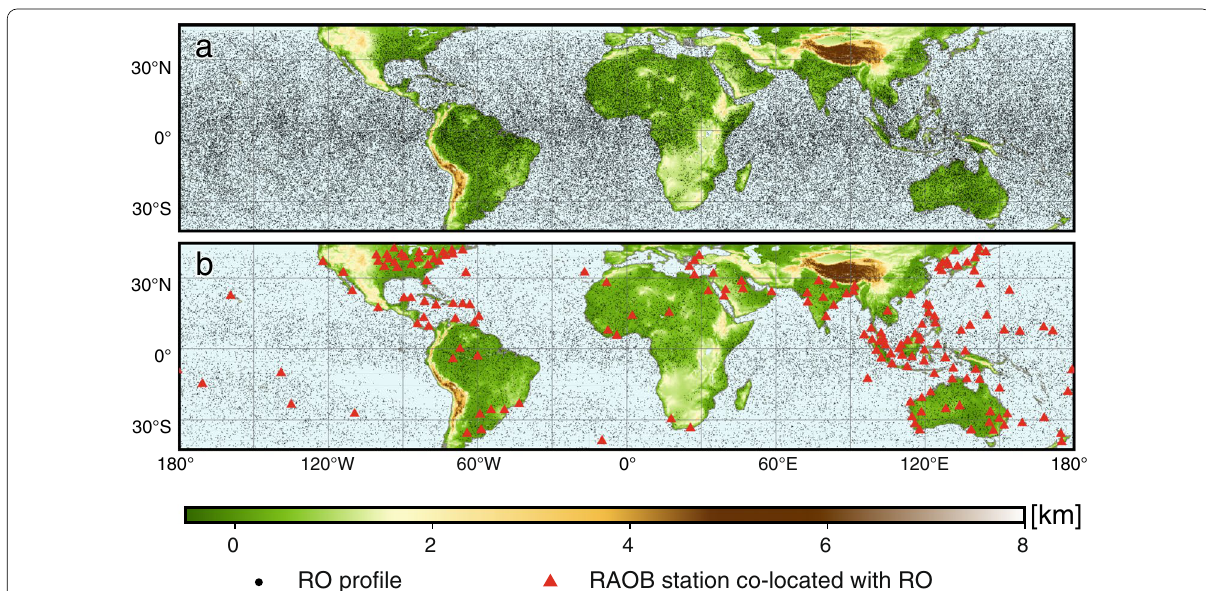
Fig. 2 Distribution of RO profiles employed in training ( a ) and testing ( b ) of machine learning models. Red triangles in ( b ) emphasizes radiosonde stations co-located with RO profiles. Background color shows terrain elevation. Note, the location and number of available RO soundings is restricted by the